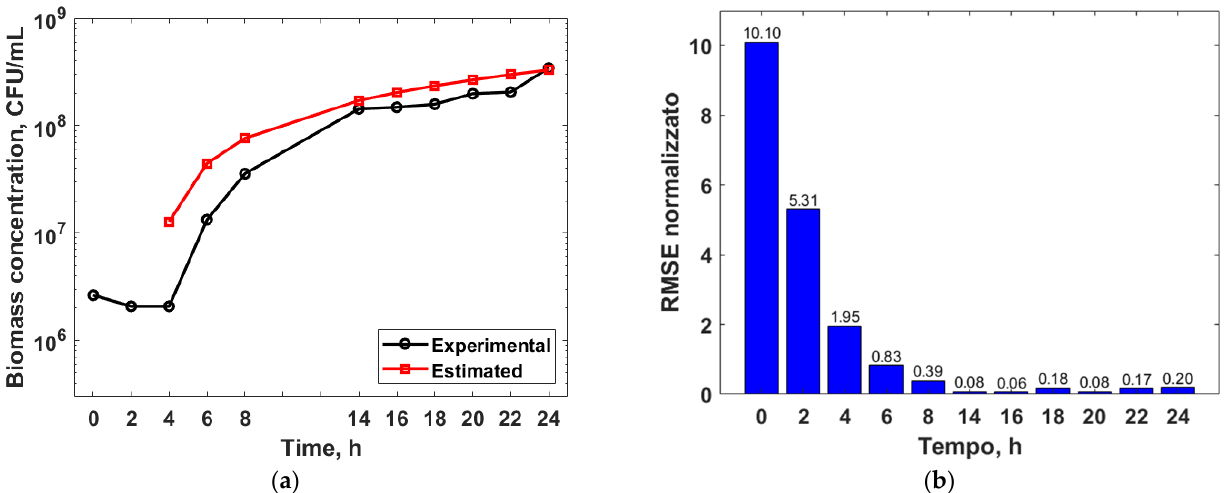
Figure 8. Genetic algorithm optimization by considering a single regression term and the response variable as a function of time and pH in case of uncontrolled pH: ( a ) comparative trends and ( b ) normalized RMSE.